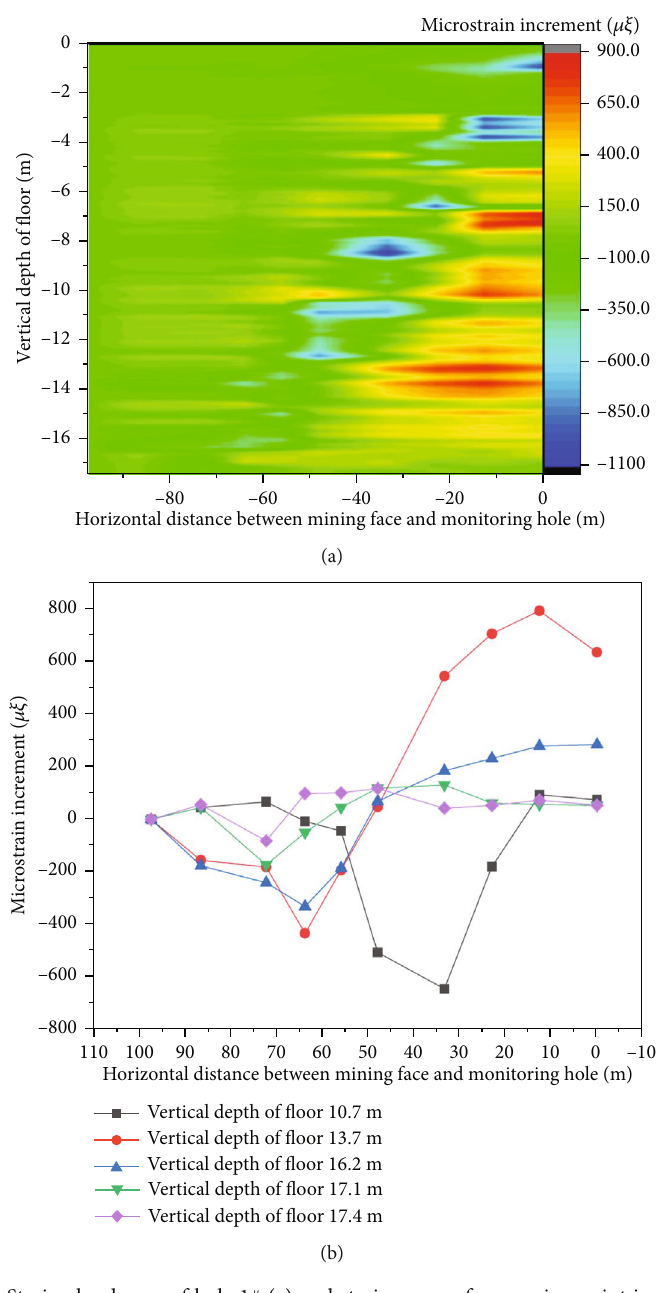
Figure 11: Strain cloud map of hole 1# (a) and strain curve of measuring point in hole 1#